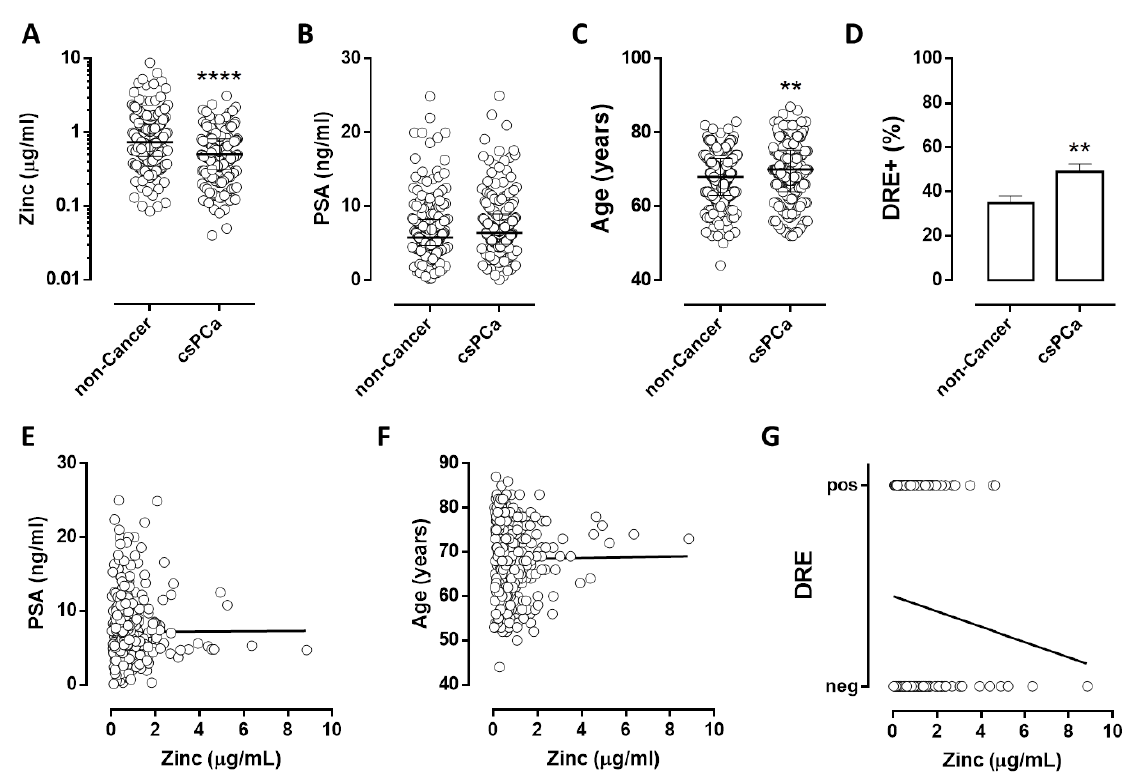
Figure 2. Urinary zinc and standard parameters in patients with clinically significant PCa: amount of zinc ( A ), serum PSA ( B ), Age ( C ), percentage of suspect DRE ( D ) in men without prostate cancer or Low-risk PCa (non-cancer, n = 204) and patients with clinically significant PCa (csPCa, n = 190). Correlation between zinc and standard parameters: PSA ( E ), Age ( F ), and DRE ( G ) in subjects candidate for prostate biopsy. ** p < 0.01, **** p < 0.0001, to non-cancer.